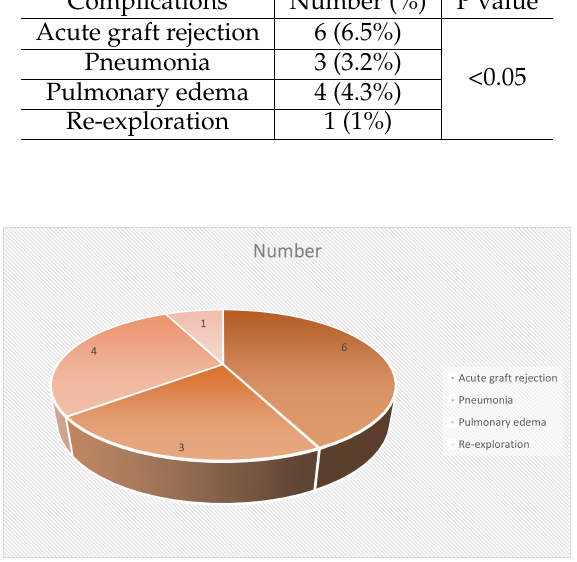
Figure 2. Complications in renal transplant